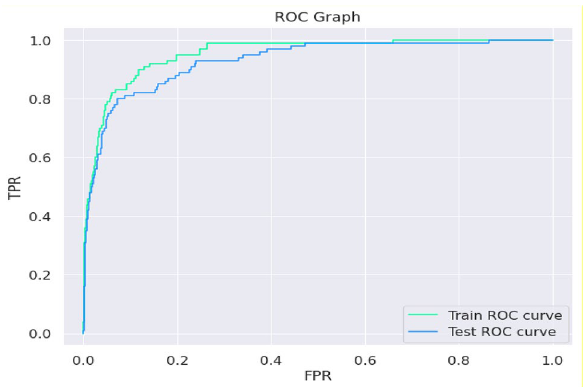
Figure 12. ROC curve attained using original data without augmentation.